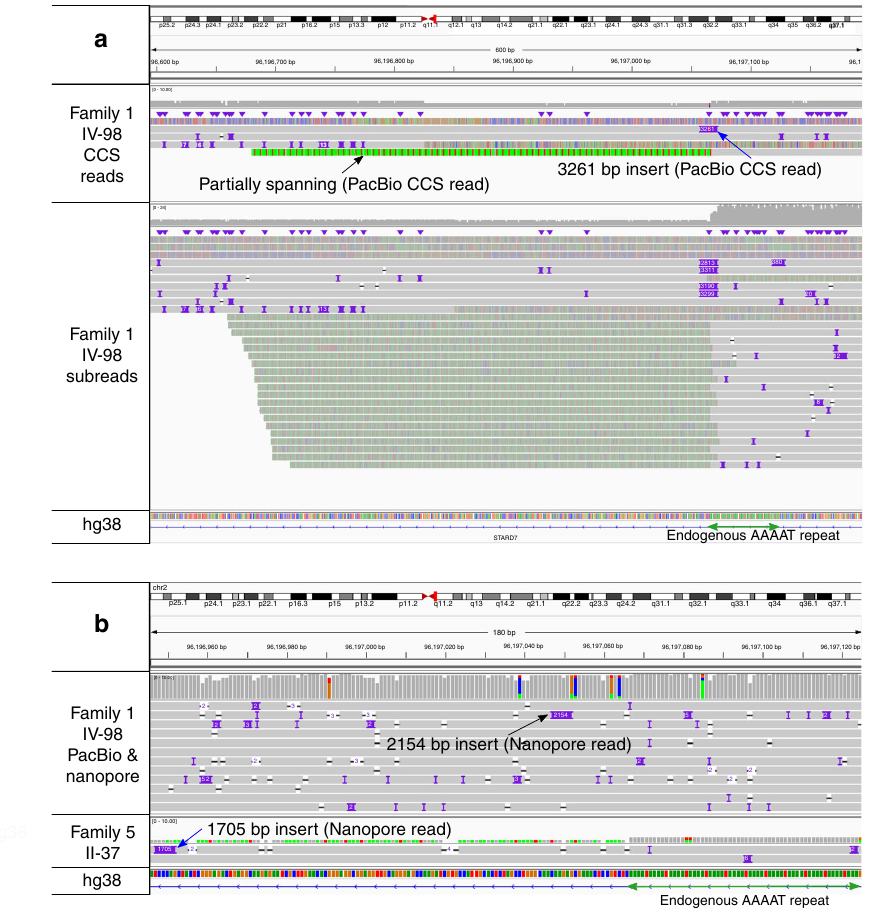
Fig. 2 Long-read sequencing identi fi es the structure of the AAATG/AAAAT repeat expansion in intron one of STARD7 . a Upper panel shows CCS reads from one member of Family 1 (IV-98) mapped to GRCh38. A read with a 3261 bp insert (blue arrow) which contains both AAATG and AAAAT sequences and fl anking sequences that map to either side of the endogenous AAAAT repeat is present. Lower panel shows the component subreads mapped to the same region. b Top panel shows combined PacBio and nanopore reads mapped to hg38, following correction with Canu v1.7, with base pair mismatches in the reads masked for clarity. For Family 1 IV-98 (upper panel), a 2154 bp insert is shown (black arrow) on IGV; however, the read sequence contains a 3672 bp combined AAATG/AAAAT repeat insertion. Lower panel shows a nanopore read in one individual from Family 5 (II-37) with a 1705 bp insert on IGV (blue arrow), however the read contains a 4645 bp combined AAATG/AAAAT repeat insertion. Complete sequences for all reads that span the repeat expansion are included in Supplementary